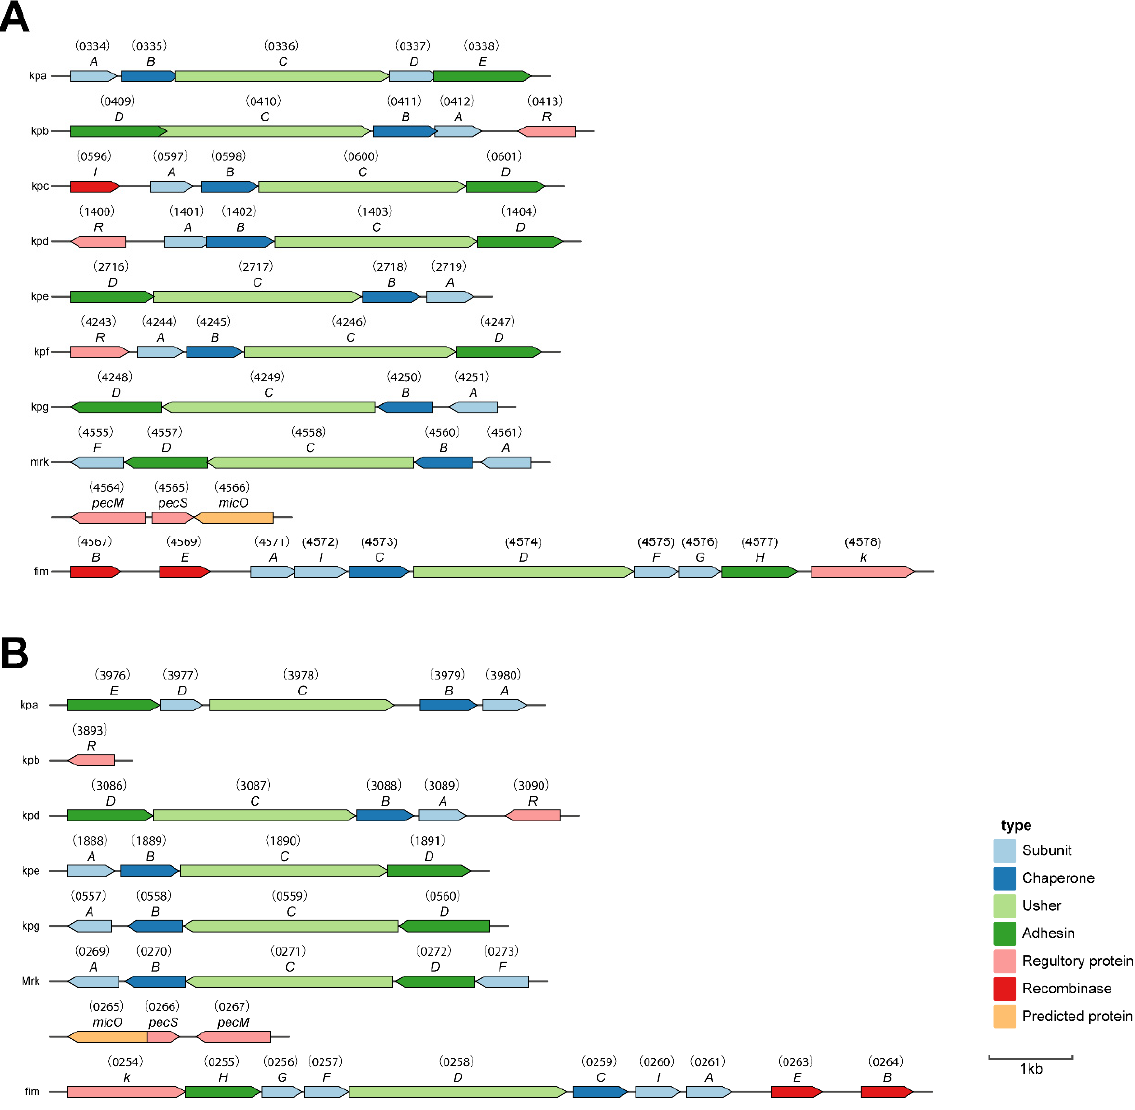
Figure 6. Fimbrial gene clusters of the chaperone–usher-dependent assembly class in K. pneumoniae KpC4 and NTUH-K2044. ( A ) NTUH-K2044 [47]. ( B ) KpC4. The locations and orientations of the open reading frames (ORFs) are indicated by arrows. The designation of putative fimbrial genes and the locus tag of ORFs were annotated in the K. pneumoniae KpC4 and NTUH-K2044 by KpC4_number and KP1_number, respectively. Each of the putative fimbrial operons is underlined. The putative functions of the ORFs are also shown.